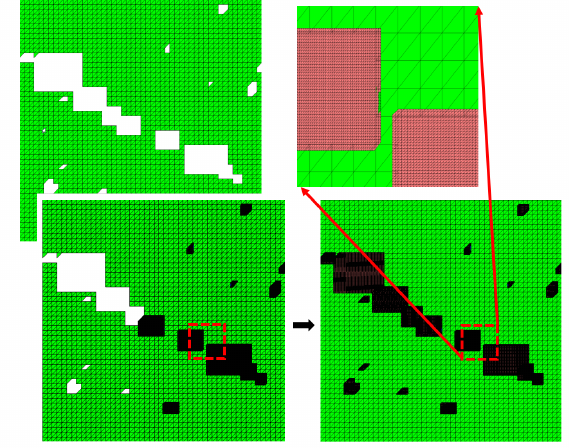
Figure 10. Mesh fusion: DTM exhibiting holes in areas which have to be corrected and filling the holes with M Label (left), detailed view of overlapping meshes: DTM and M Label (right).